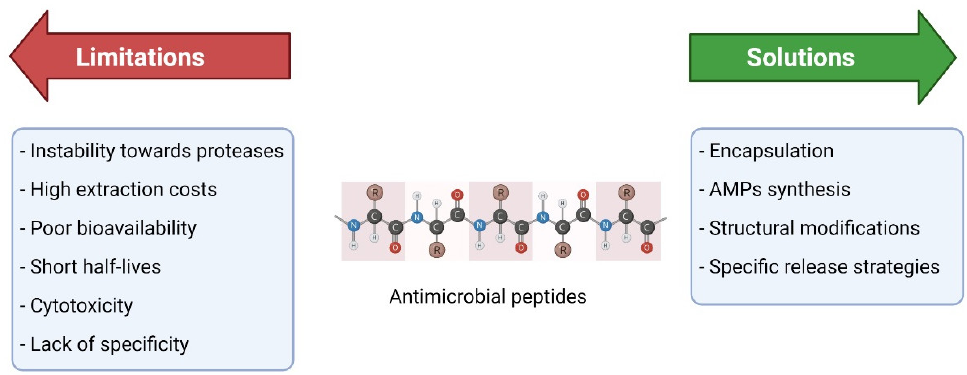
Figure 2. Limitations of AMPs and possible solutions for their therapeutic use.